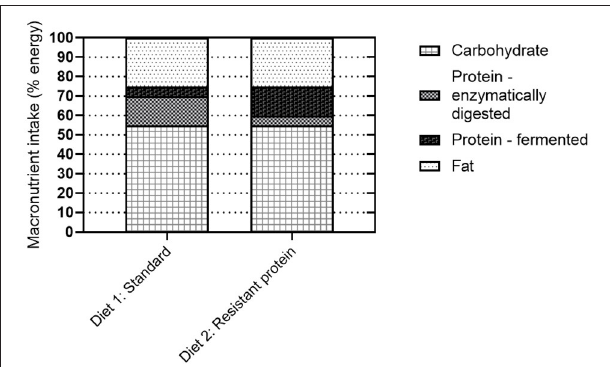
FIGURE 8 | Schematic demonstrating the proportion of protein that is enzymatically digested vs. fermented by the gut microbiota as a function of protein resistance (standard or resistant